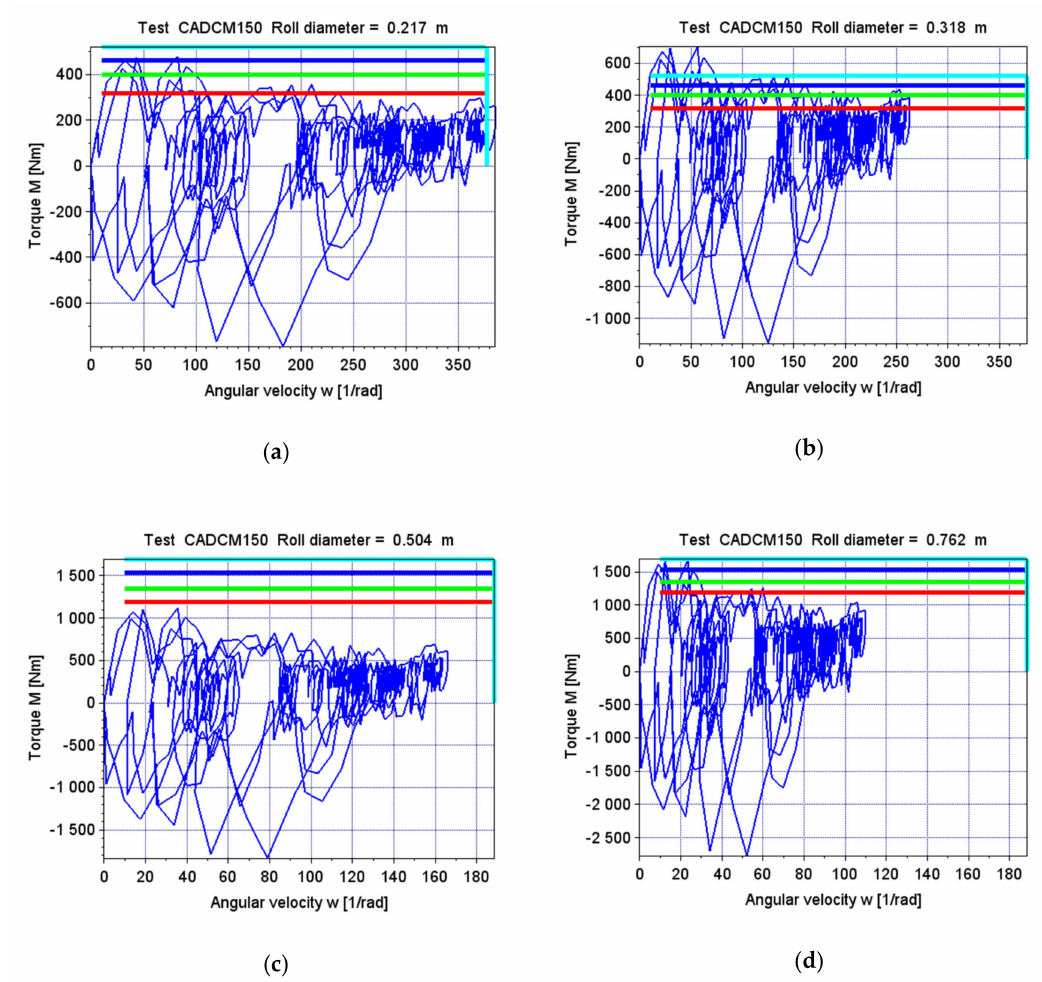
Figure 5. Simulation results for the CADCM150 test in waveforms of rotational speed and torque of the dynamometer brake for changes in the diameter of the brake rollers: ( a ) 0.217 m—ECP 34-1S / 2—Power 120 kVA red line; ECP 34-2S / 2—Power 150 kVA green line; ECP34-1L / 2—Power 174 kVA blue line; ECP 34-2L / 2—Power 196 kVA light blue line; ( b ) 0.318 m—ECP 34-1S / 2—Power 120 kVA red line; ECP 34-2S / 2—Power 150 kVA green line; ECP34-1L / 2—Power 174 kVA blue line; ECP 34-2L / 2—Power 196 kVA light blue line; ( c ) 0.504 m—ECO38 1S4 A—Power 225 kVA red line; ECO38 2S4 A—Power 253 kVA green line; ECO38 3S4 A—Power 289 kVA blue line; ECO38 1L4 A—Power 319 kVA light blue line; ( d ) 0.762 m—ECO38 1S4 A—Power 225 kVA red line; ECO38 2S4 A—Power 253 kVA green line; ECO38 3S4 A—Power 289 kVA blue line; ECO38 1L4 A—Power 319 kVA light blue